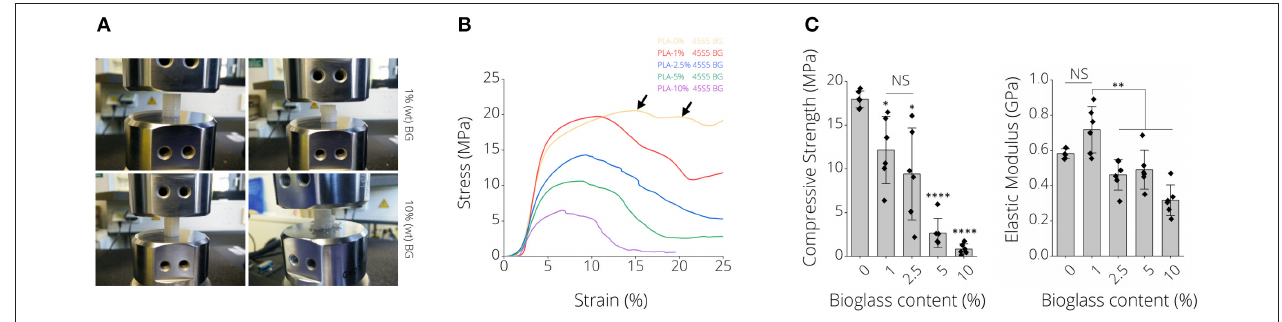
FIGURE 4 | Mechanical properties of 3D printed PLA-45S5 BG scaffolds. (A) Macroscopic images illustrating different failure modes of 1 and 10% (wt) BG loaded PLA-BG scaffolds indicating buckling and brittle failure, respectively. (B) Qualitative stress strain diagram from compression tests of PLA-0, 1, 2.5, 5, and 10%-BG laden 3D printed scaffolds. A loss in scaffold toughness with increasing BG content is visible. The consecutive failure of different layers inside the scaffolds during compression testing is indicated by stress hills (black arrow) inside the diagram after initial failure of a scaffold layer. (C) Compression strength and modulus of